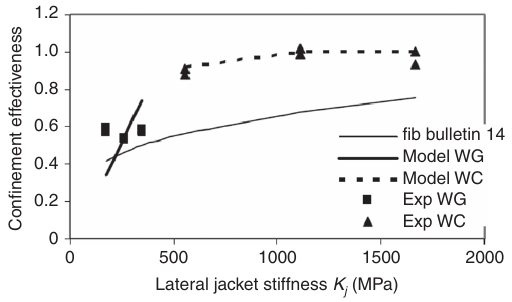
Figure 13 Normalized ultimate axial stress for CFRP-confined concrete specimens.